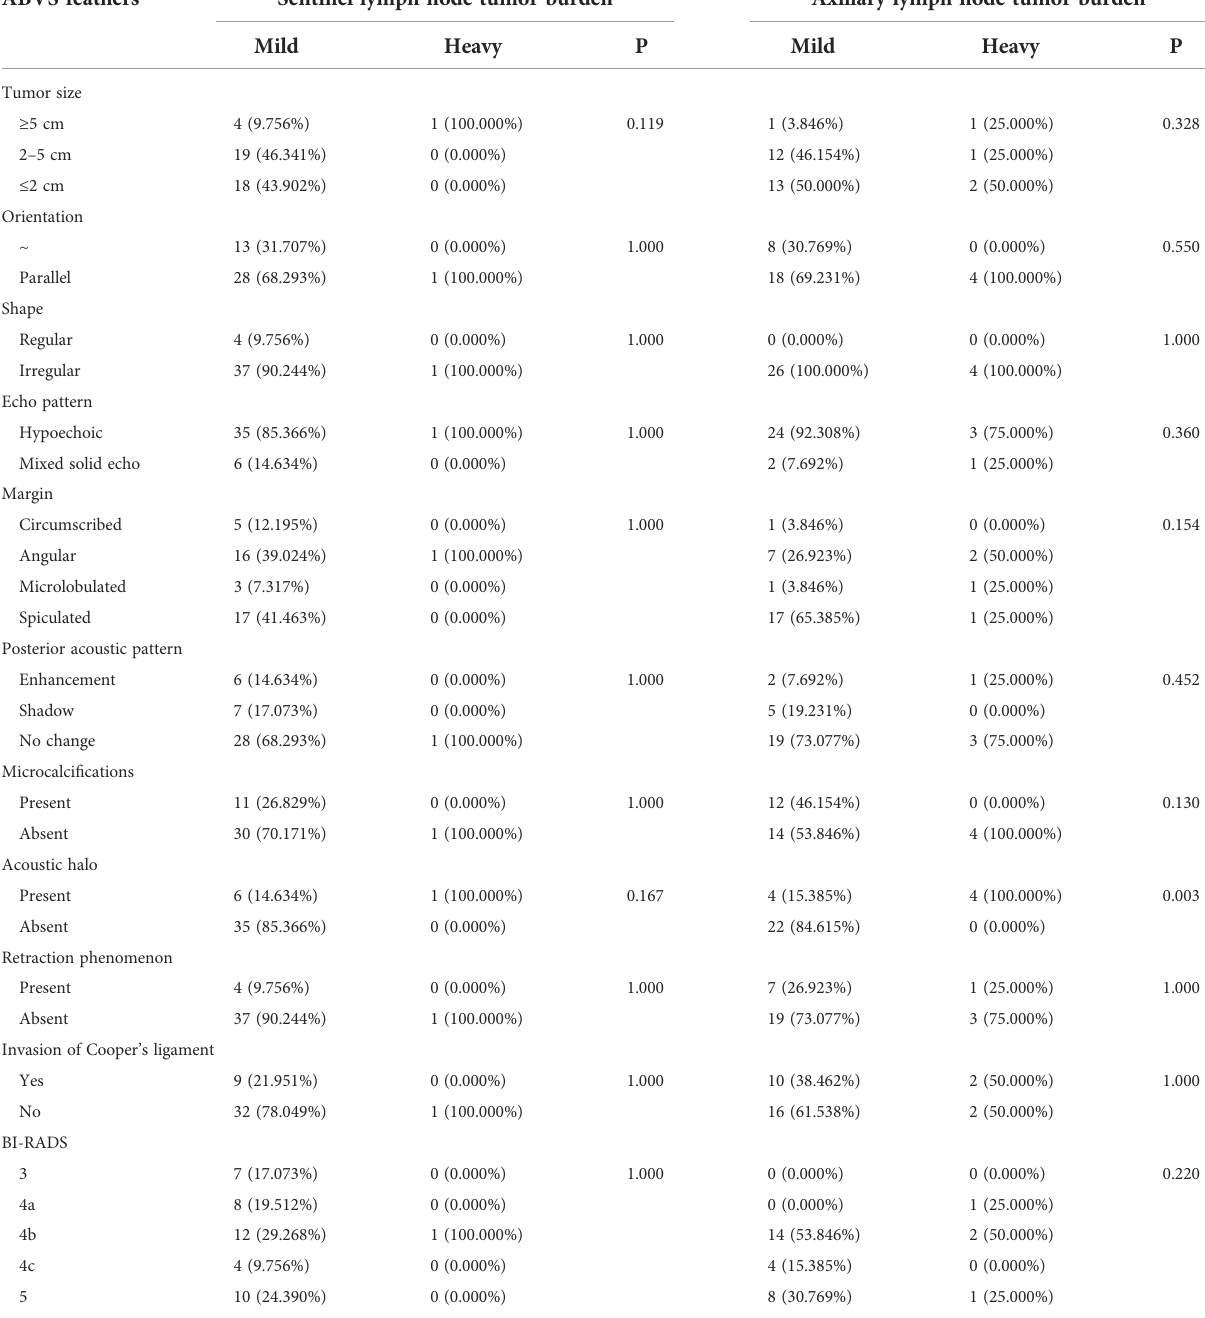
TABLE 2 Differences of lymph node tumor burden of luminal A-type breast cancer regarding different ABVS feathers. ABVS